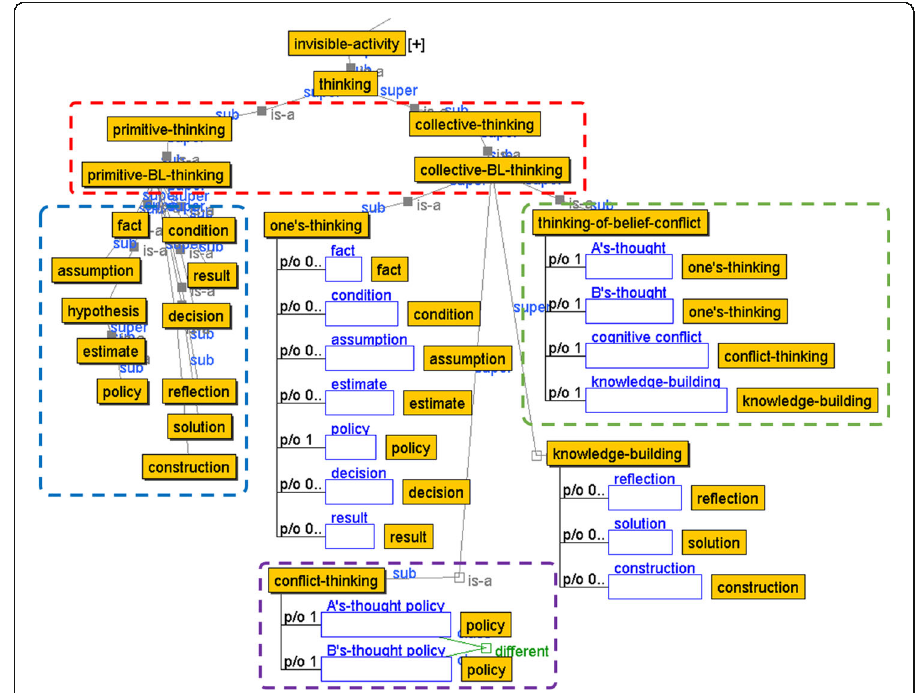
Fig. 2 Concepts of output of base-level thinking activity in thinking of belief